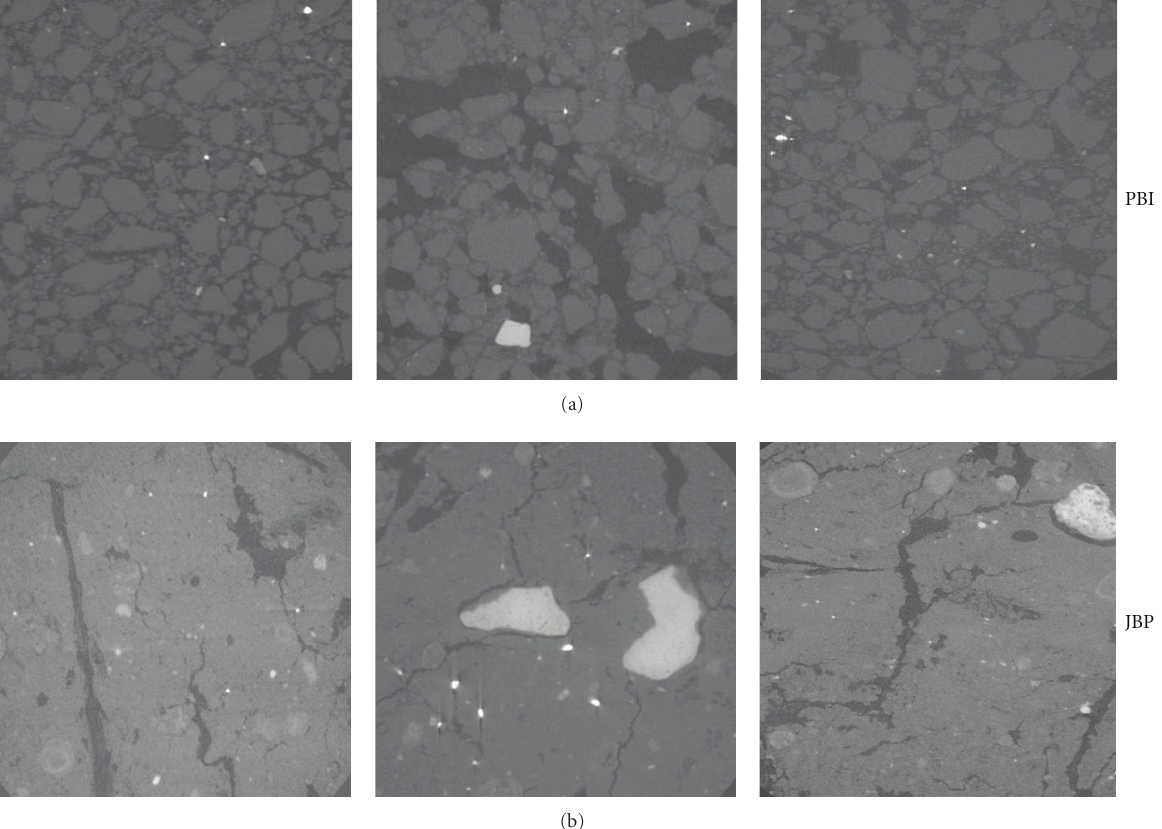
Figure 6: Internal distribution of porosity. PBI is shown at the top and JBP is shown at the bottom. For each site, samples 1, 2 and 3 are ordered